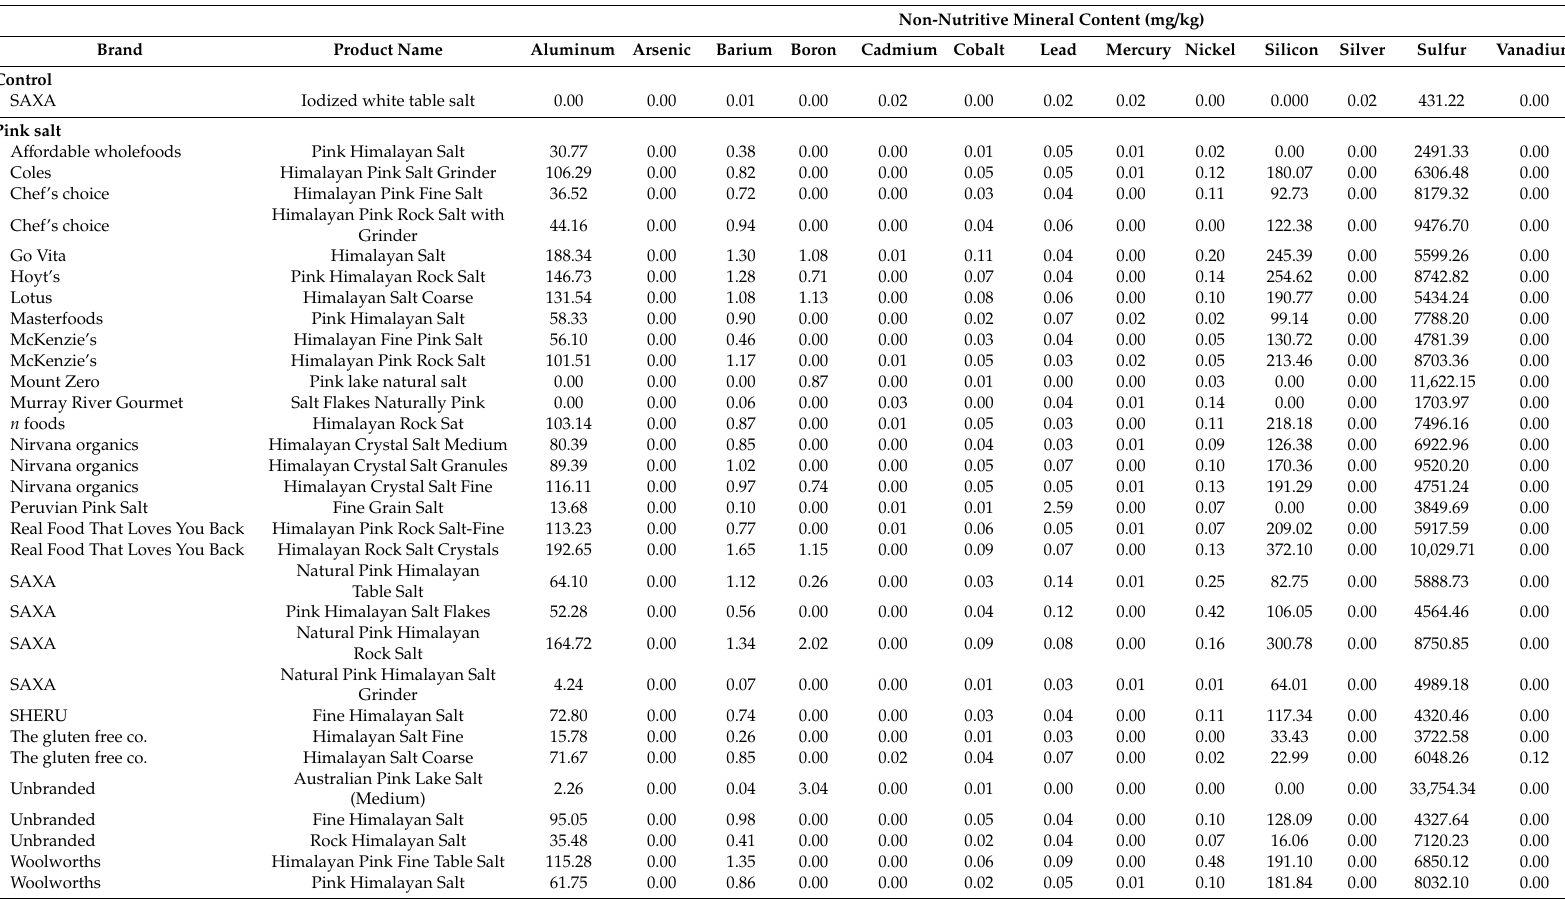
Table 3. Composition of non-nutritive minerals in pink salt ( n = 31) and iodized white table salt ( n = 1) samples which were purchased from retail stores in Australia in June